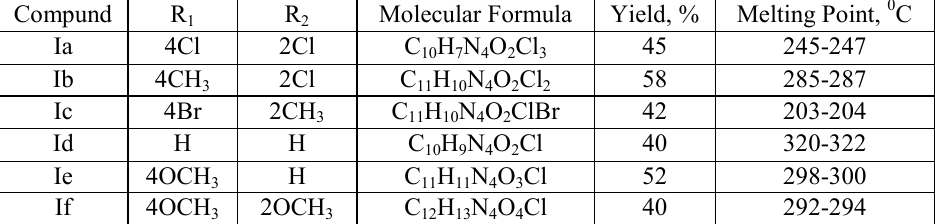
Table 1. Physical and analytical data of compound I and its other substituted derivatives. Compund R R Molecular Formula Yield, % Melting Point, 0 C 1 2